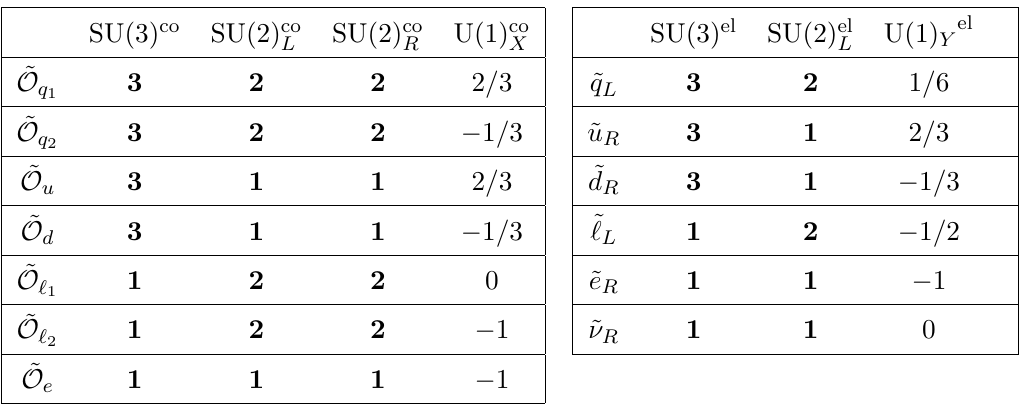
Table 2 . Group representations and charges of the fermion composite resonances and elementary